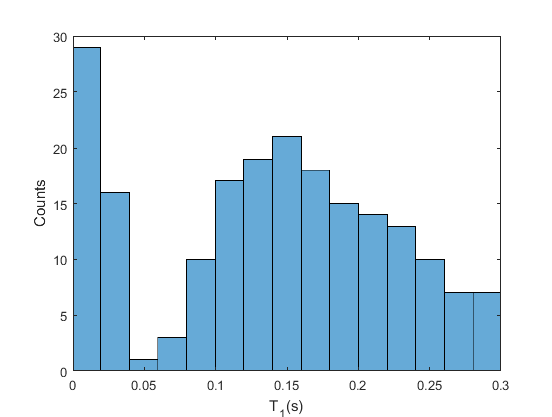
Figure 5. Histogram of times of application of u 1 in the linear model of the air levitation system.